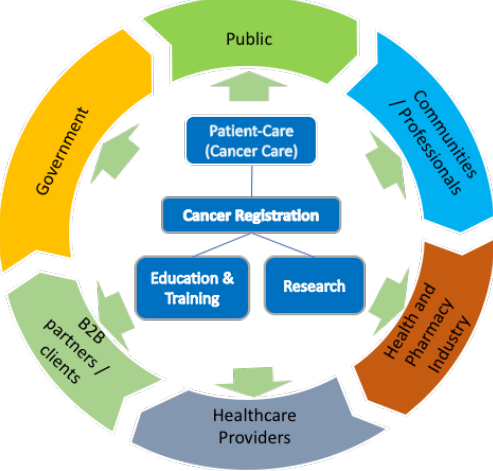
Figure 7. High-level Business Process Diagram.